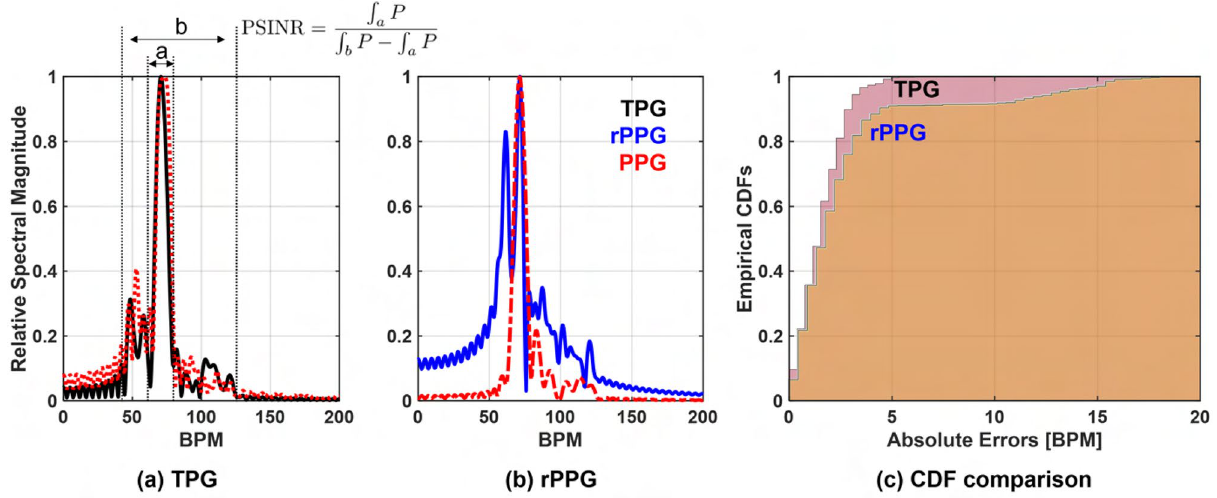
Figure 13. Pulse sensitivity study in the TPG and the rPPG measurements. ( a , b ) Visualization of pulse sensitivity in the TPG and the rPPG, and quantification of pulse sensitivity using the PSINR metric; ( c ) comparison of HR estimation performance in the form of empirical CDF from the TPG and the rPPG.